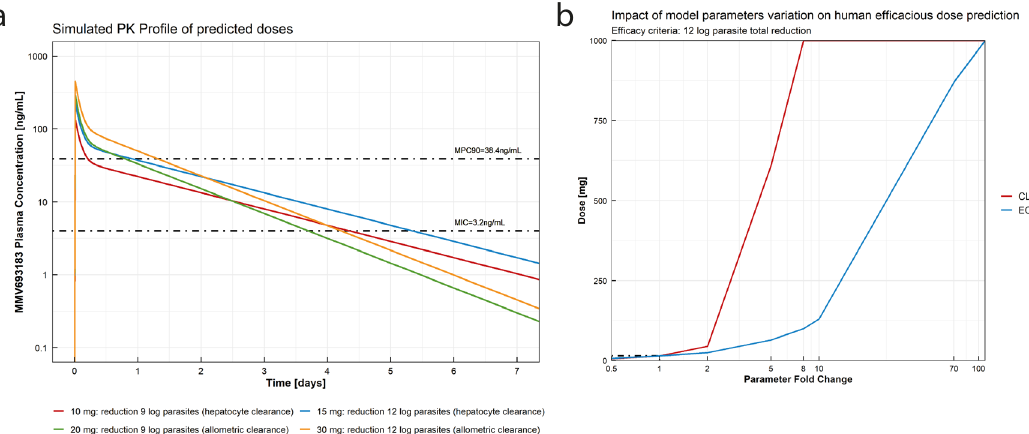
Fig. 4 Human ef fi cacious dose prediction. a MMV693183 plasma concentration after the predicted ef fi cacious human doses of 10, 15, 20, and 30 mg according to the ef fi cacy criteria and human clearance prediction method. b Local sensitivity analysis of the impact of total clearance and EC 50 variation on the estimated ef fi cacious dose, de fi ned by a 12 log total parasite reduction ef fi cacy criteria based on the prediction with the in vitro hepatocyte clearance